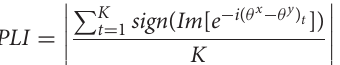
Frontiers in Molecular Neuroscience |